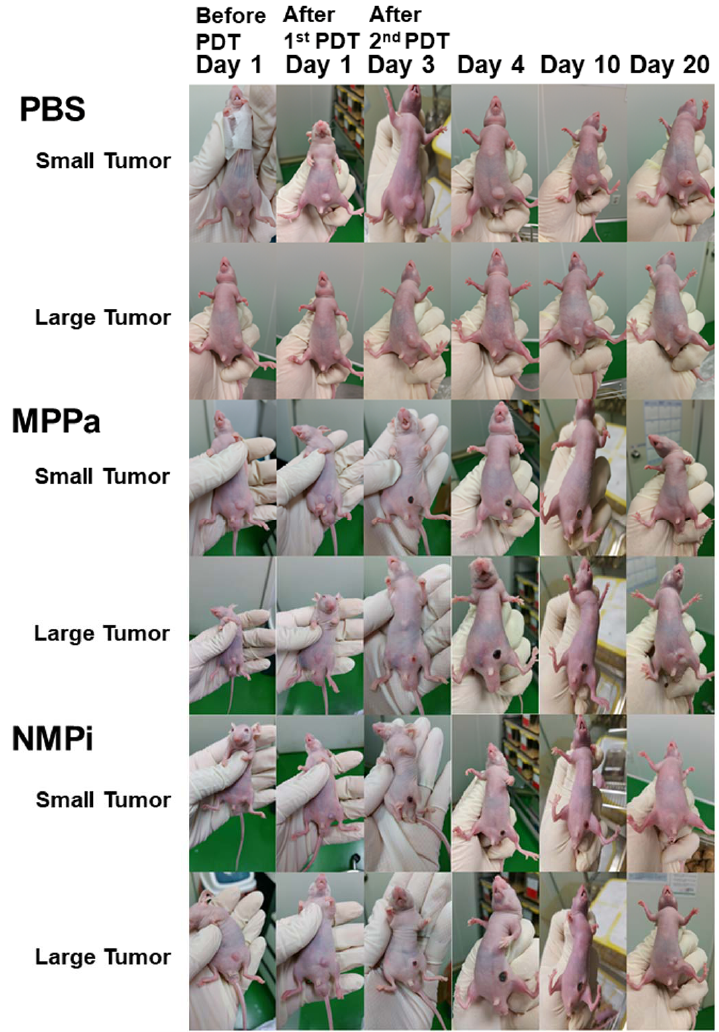
Figure 8. Tumor surface alterations of A549 tumor ‐ bearing mice (small ‐ tumor group <50 mm 3 and large ‐ tumor group >50 mm 3 ) after double intravenous injection (on Days 0 and 2, repeated two times PDT) of PBS, MPPa (2 mg/kg), and NMPi (2 mg/kg) with 200 J/cm 2 light irradiation on one day after each injection (on Days 1 and 3, repeated two times PDT). Mice in the small ‐ tumor group (<50 mm 3 ) treated with MPPa and NMPi under PDT revealed complete tumor eradication on Day 20. However, in large ‐ tumor group (>50 mm 3 ), tumor tissues were not completely eliminated.